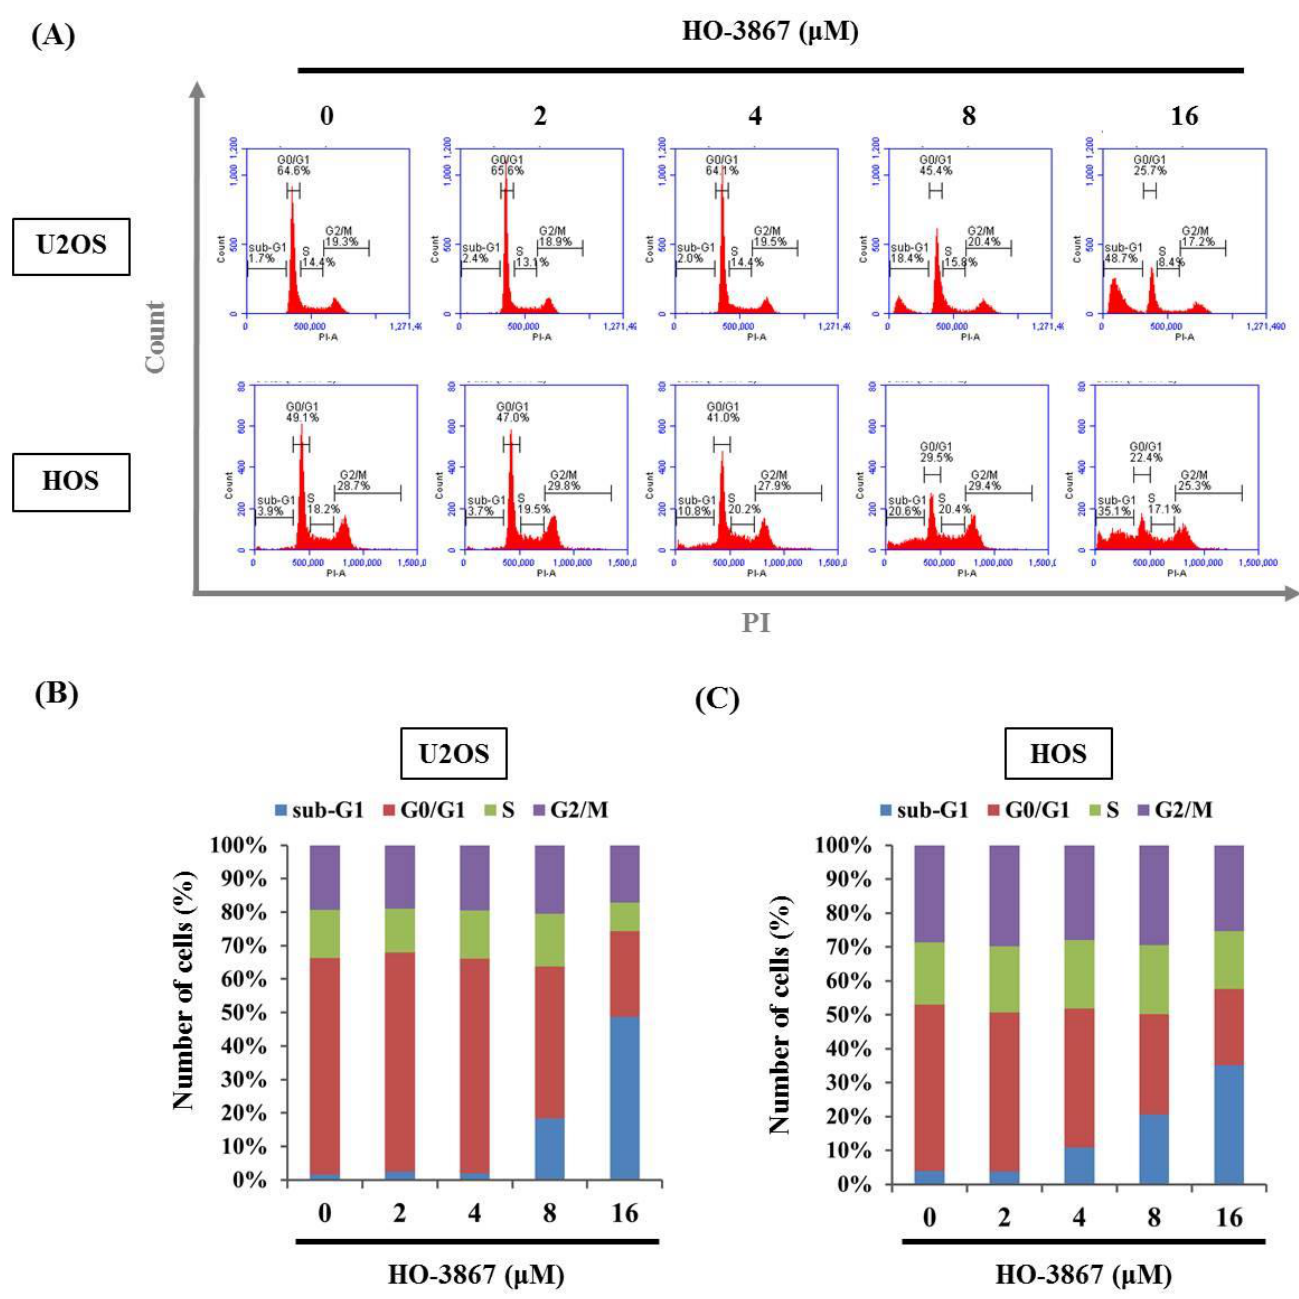
Figure 2. Analysis of cell cycle in HO-3867 treated U2OS and HOS cells. ( A ) After treatment with experimental concentration range of HO-3867 for 24 h, flow cytometry after PI was performed to determine DNA contents in U2OS and HOS cells; ( B , C ) The cell cycle profile of flow cytometry was subsequently